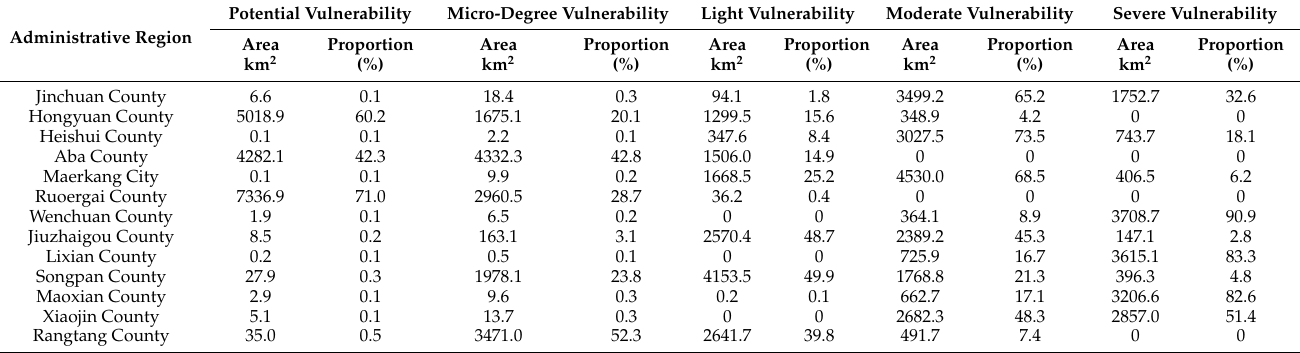
Table 9. Area proportions of socio-ecological vulnerability grades in administrative regions, Aba